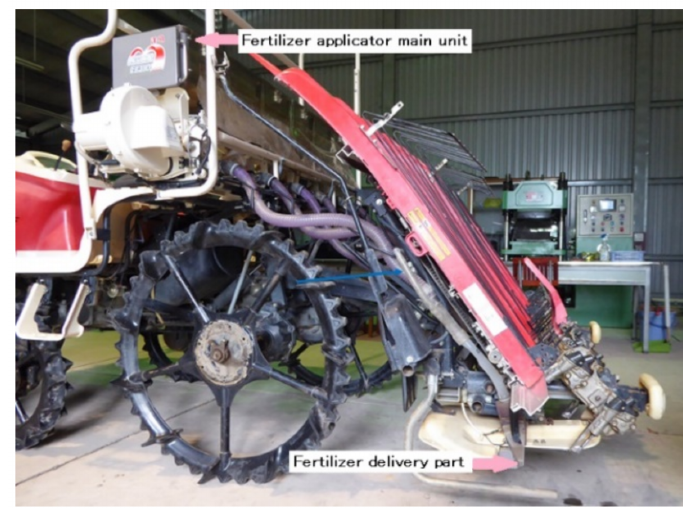
Figure 15. Fertilizer applicator mounted on a rice transplanter. Side strip fertilization device is equipped, fertilizer to be delivered to the beneath of the soil. Source: Photo was taken by the author at Can Tho city in December